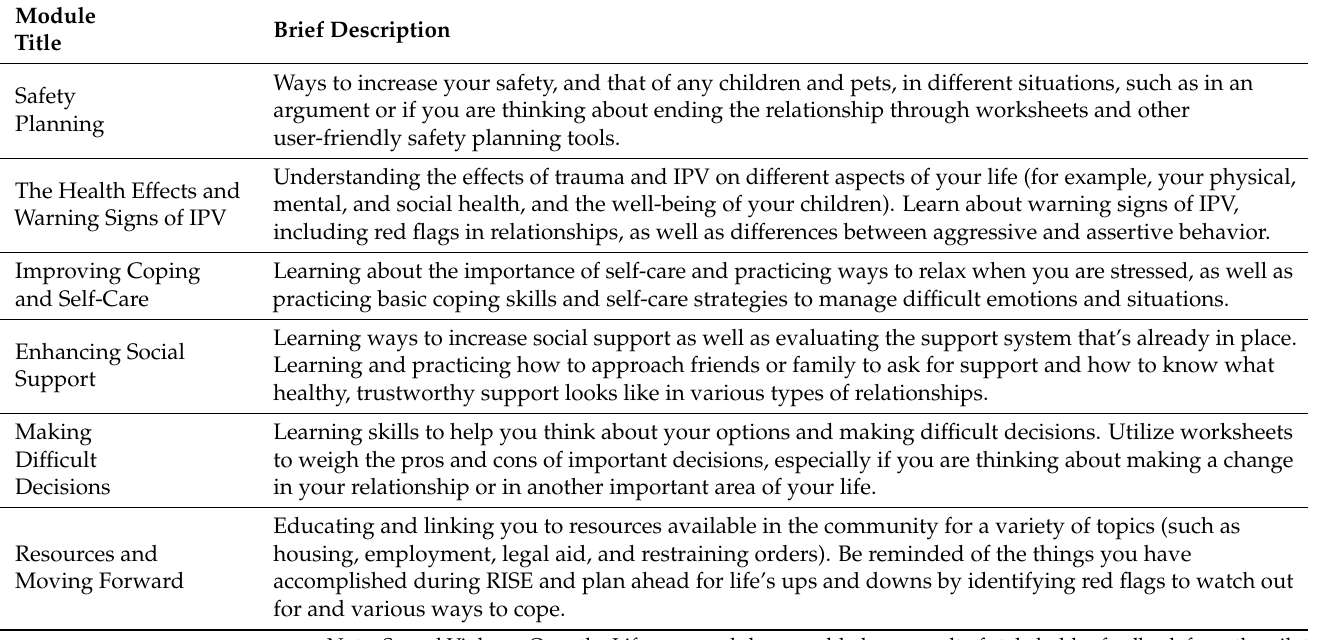
Table 1. Descriptions of the Modules Patients Select from during a RISE